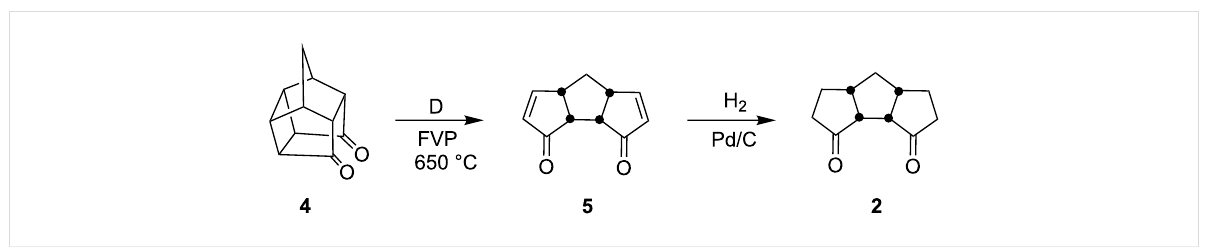
Scheme 1: Synthesis of tricyclic diones 5 and 2